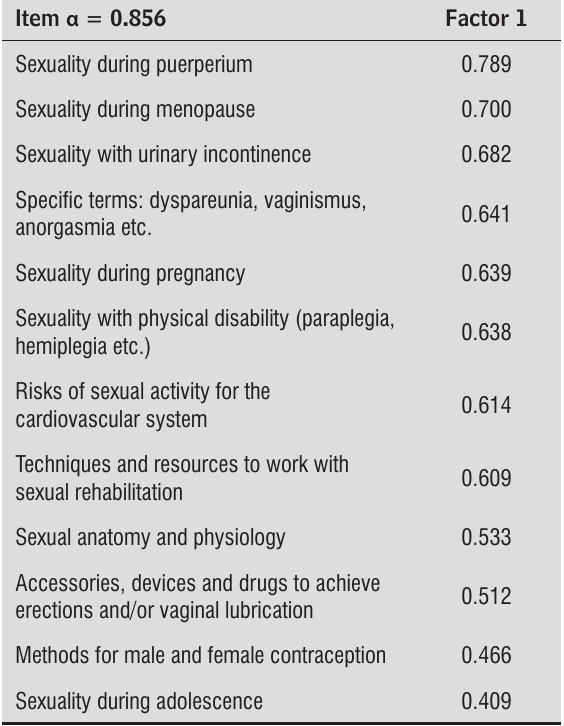
Table 1 - Factor analysis from the extraction of the knowl-